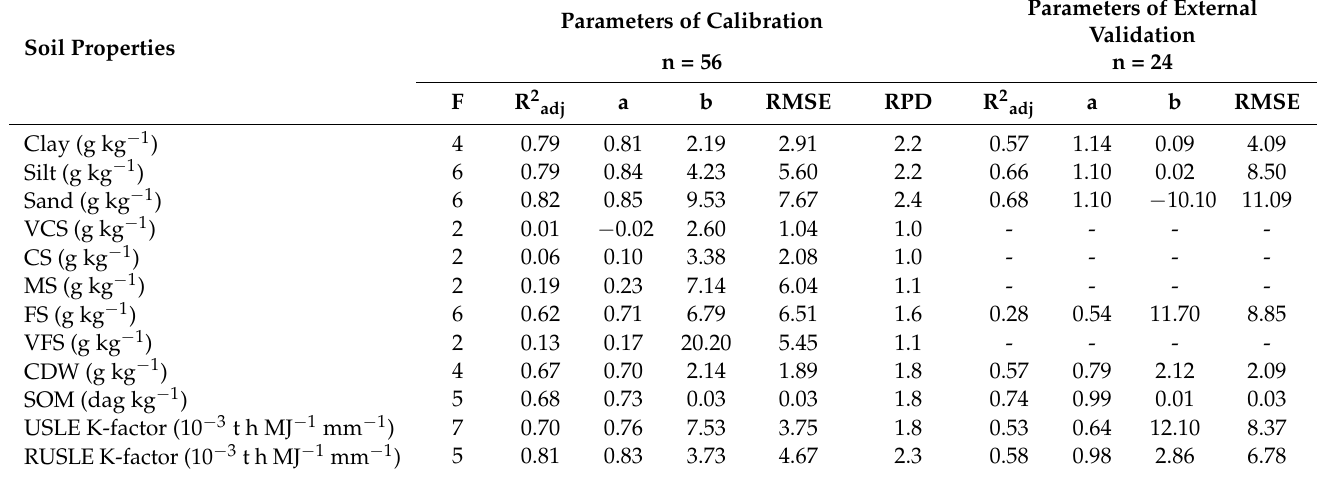
Figure 6. Changes in spectral reflectance of the data from different soil-texture classes after nor- malization by standard normal variate (SNV) method. Each color represents the average of the correspondent class. Table 3. Summary of results obtained through PLSR by cross validation and parameters of the external validation of the studied soil